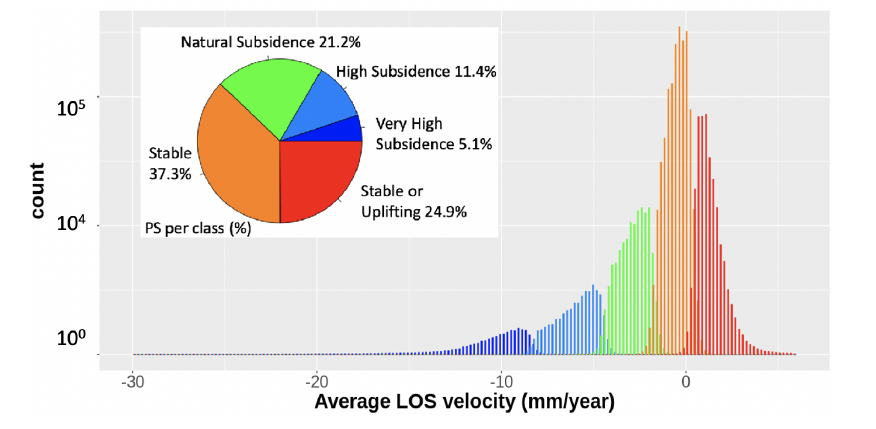
Figure 6. The figure shows the histogram of LOS velocities divided by clusters. According to the histogram, each cluster has a well-defined average LOS velocity. The pie chart shows how PS are distributed within each cluster.